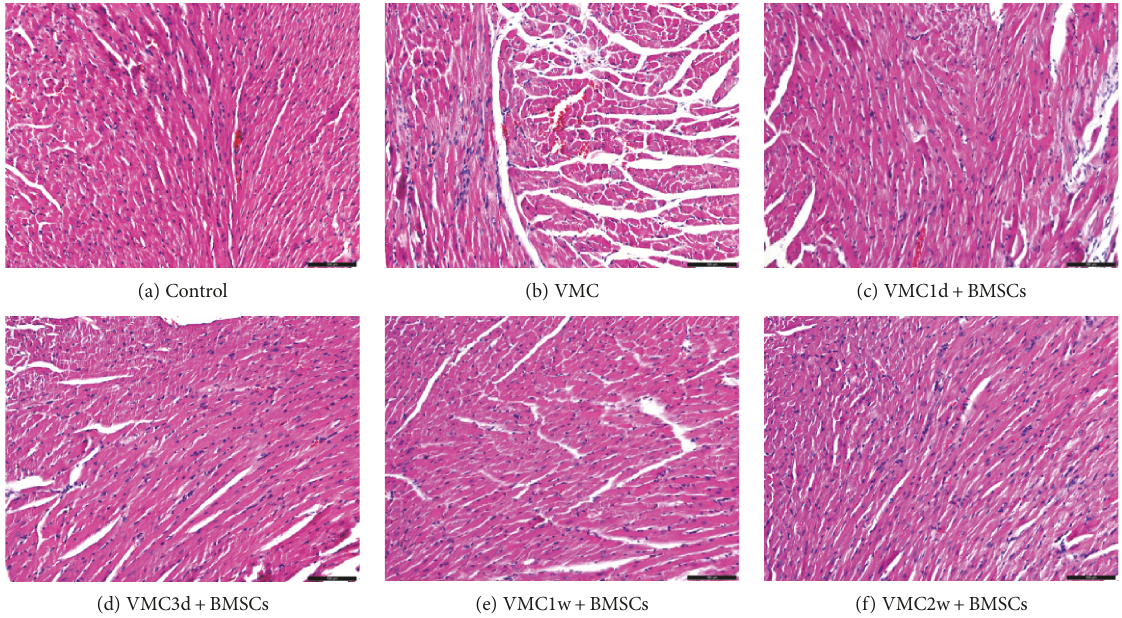
Figure 1: Histological fi ndings of myocardial tissues after BMSCs transplantation. The scale bars are equal to 100 μ m in all of the images. (a) Control group. Histological fi ndings of myocardial tissues in 4 weeks after PBS intraperitoneal injection. The myocardium was arranged neatly with clear contours and no obvious in fl ammatory cell in fi ltration (H&E, × 200). (b) VMC, the myocarditis group. Histological fi ndings of myocardial tissues within 4 weeks after CVB3 intraperitoneal injection. The myocardium was disordered and showed residual in fl ammatory in fi ltration and necrotic lesions (H&E, × 200). (c – f) The BMSCs treatment subgroups. Histological fi ndings of myocardial tissues within 4 weeks after CVB3 intraperitoneal injection. Mice in the VMC1d+ BMSCs, VMC3d +BMSCs, VMC1w+BMSCs, and VMC2w+BMSCs subgroups were injected with BMSCs (1 × 10 6 cells of each mouse with 100 μ l PBS) into their tail vein on the 1st day, 3rd day, 1st week, and 2nd week after they were infected by CVB3, respectively. The myocardium showed clear contours and no obvious in fl ammatory cell in fi ltration (H&E, ×